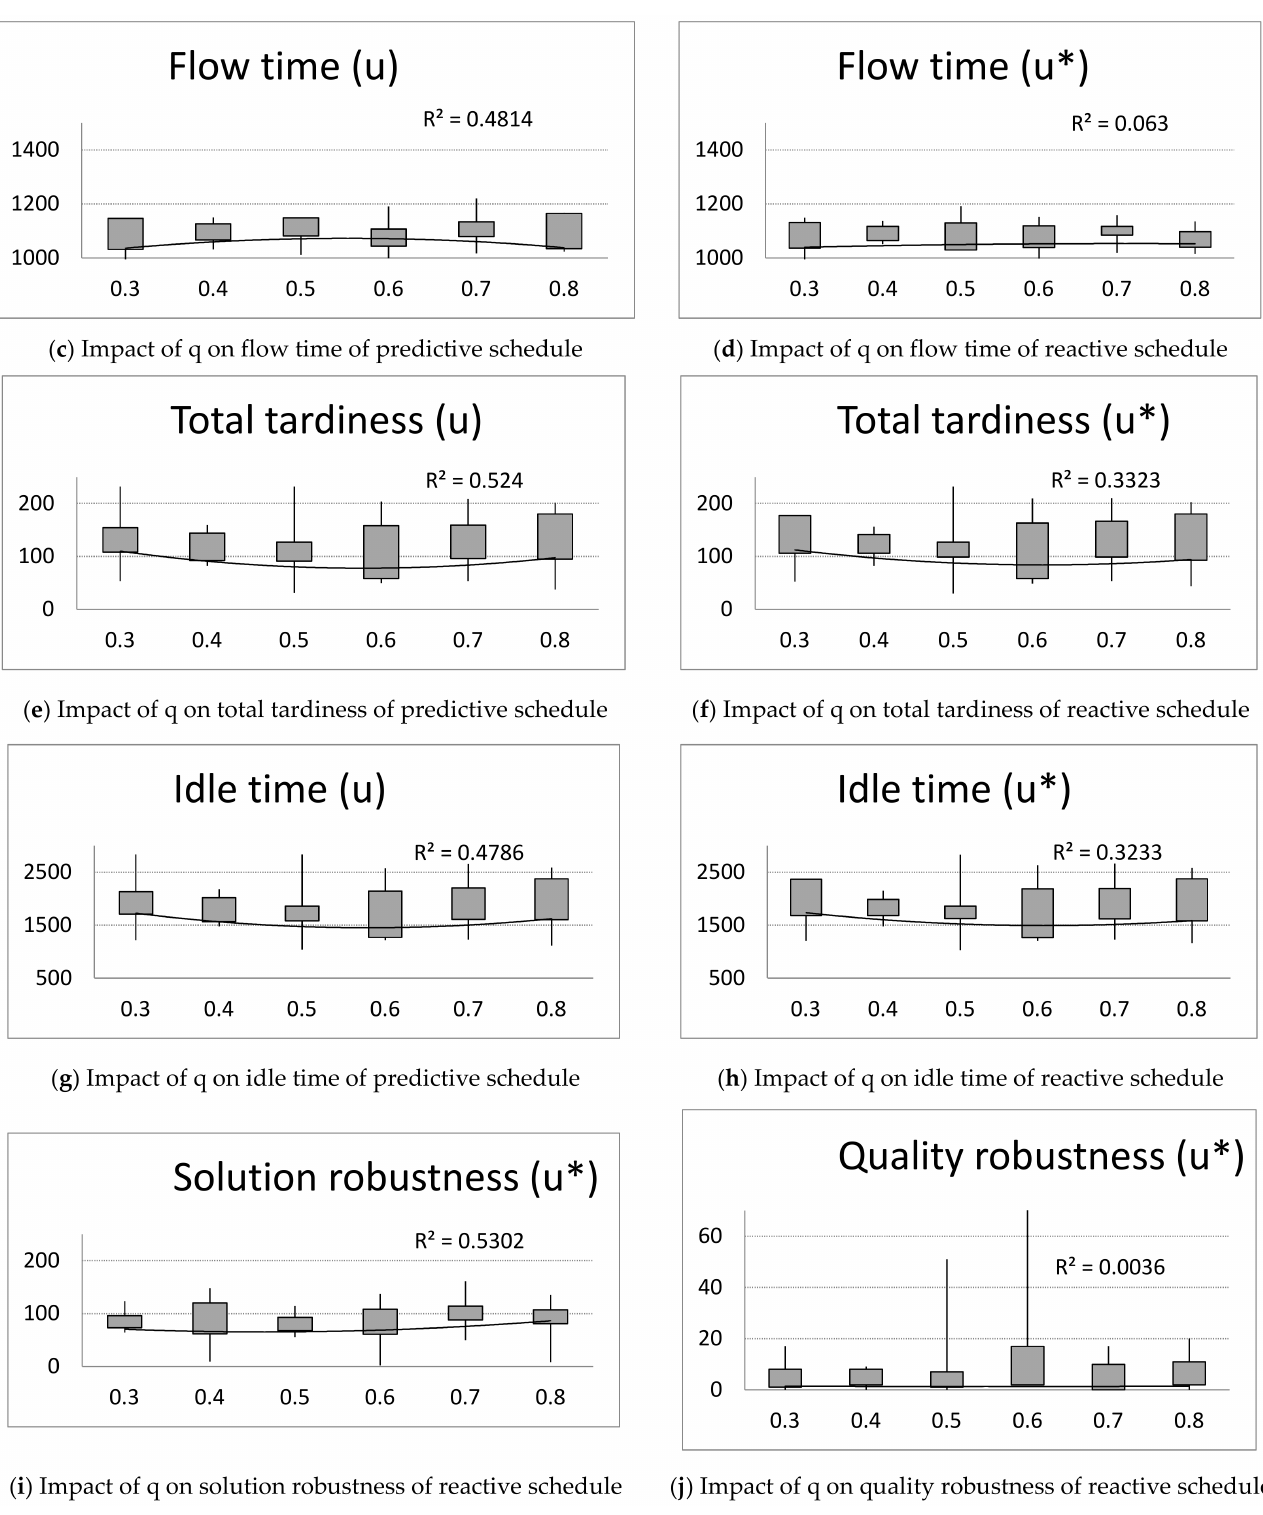
Figure 5. The impact of parameter q = {0.3, 0.4, 0.5, 0.6, 0.7, 0.8} on makespan, flow time, total tardiness, and idle time of predictive schedules (u) and reactive schedules ( u* ), and solution robustness and quality